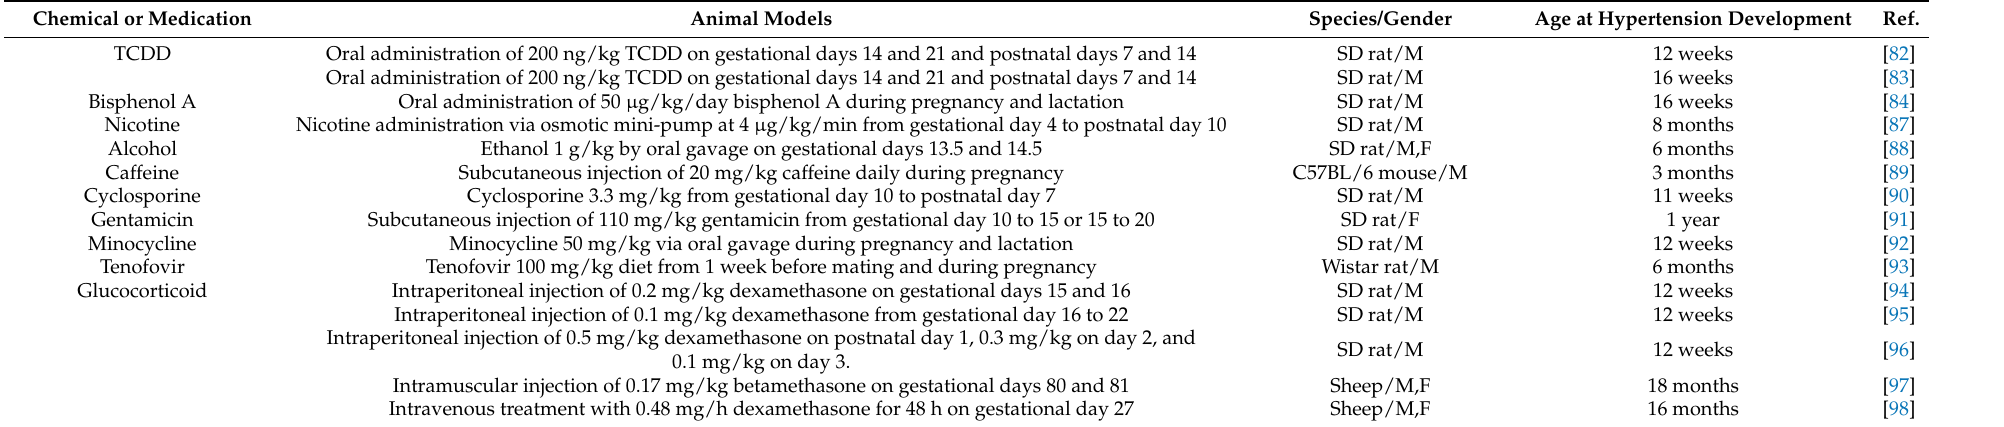
Table 2. Summary of animal models of the developmental programming of hypertension, categorized according to chemical and medication